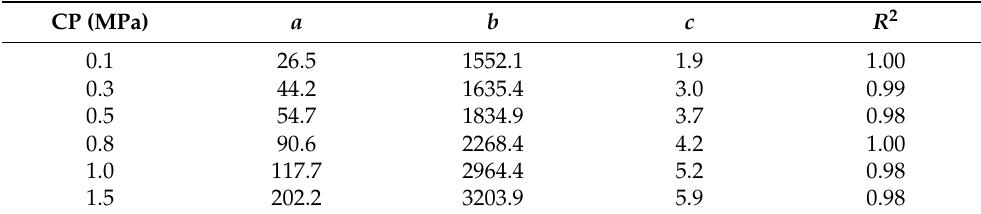
Table 5. The corresponding correlation coefficients were all greater than 0.977. Table 5. Calculated values for parameters a, b, and